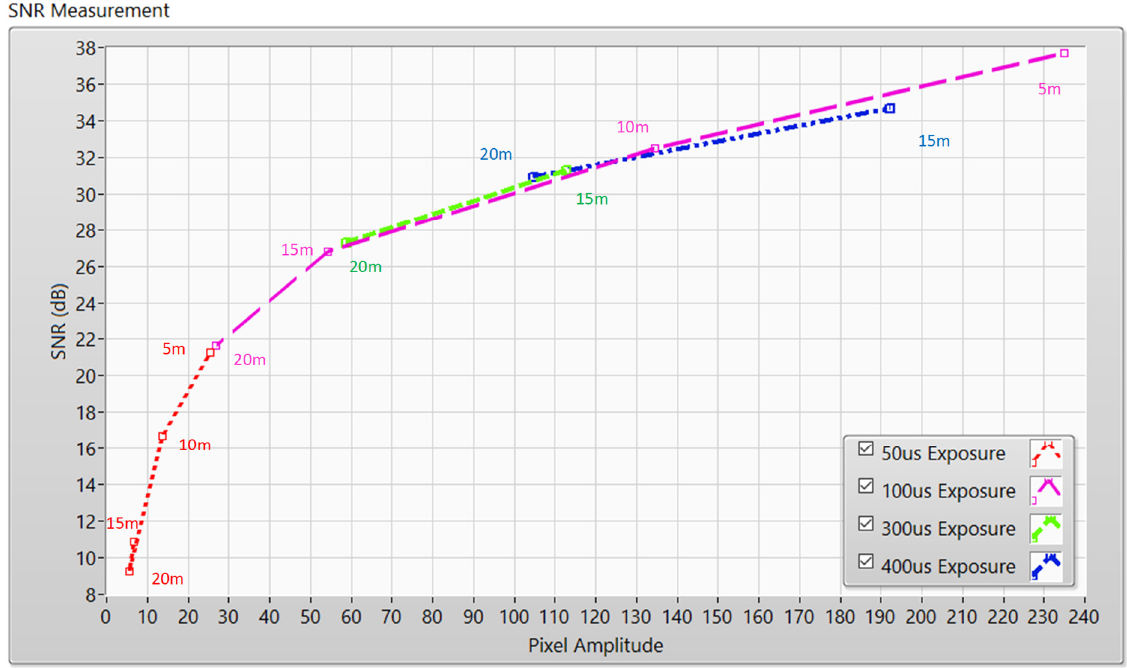
Figure 10. The SNR measurements.